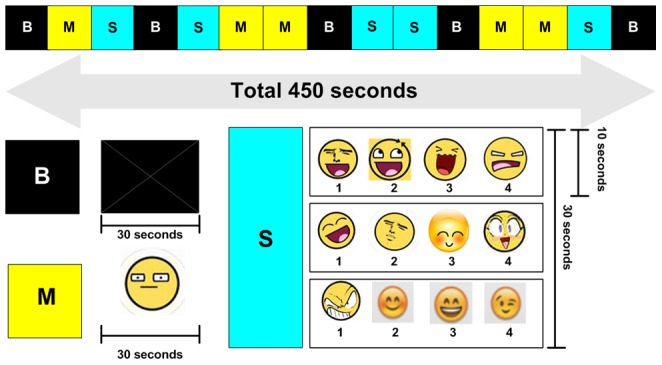
Facial emoticons.